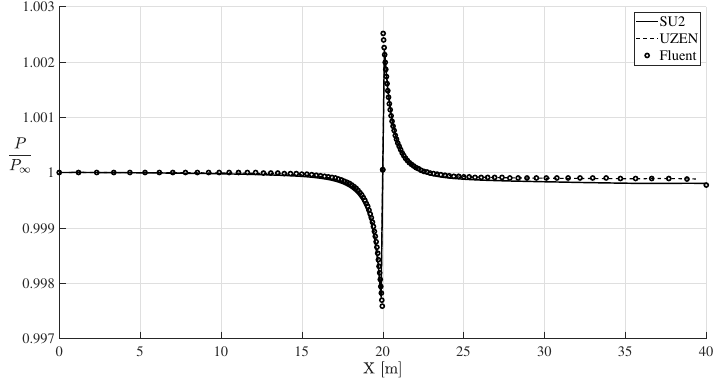
Figure 10. Pressure profile along streamline y = 0.6 m at z = 0 m section. Non-dimensional stream-wise velocity component is compared in Figure 11 at the same